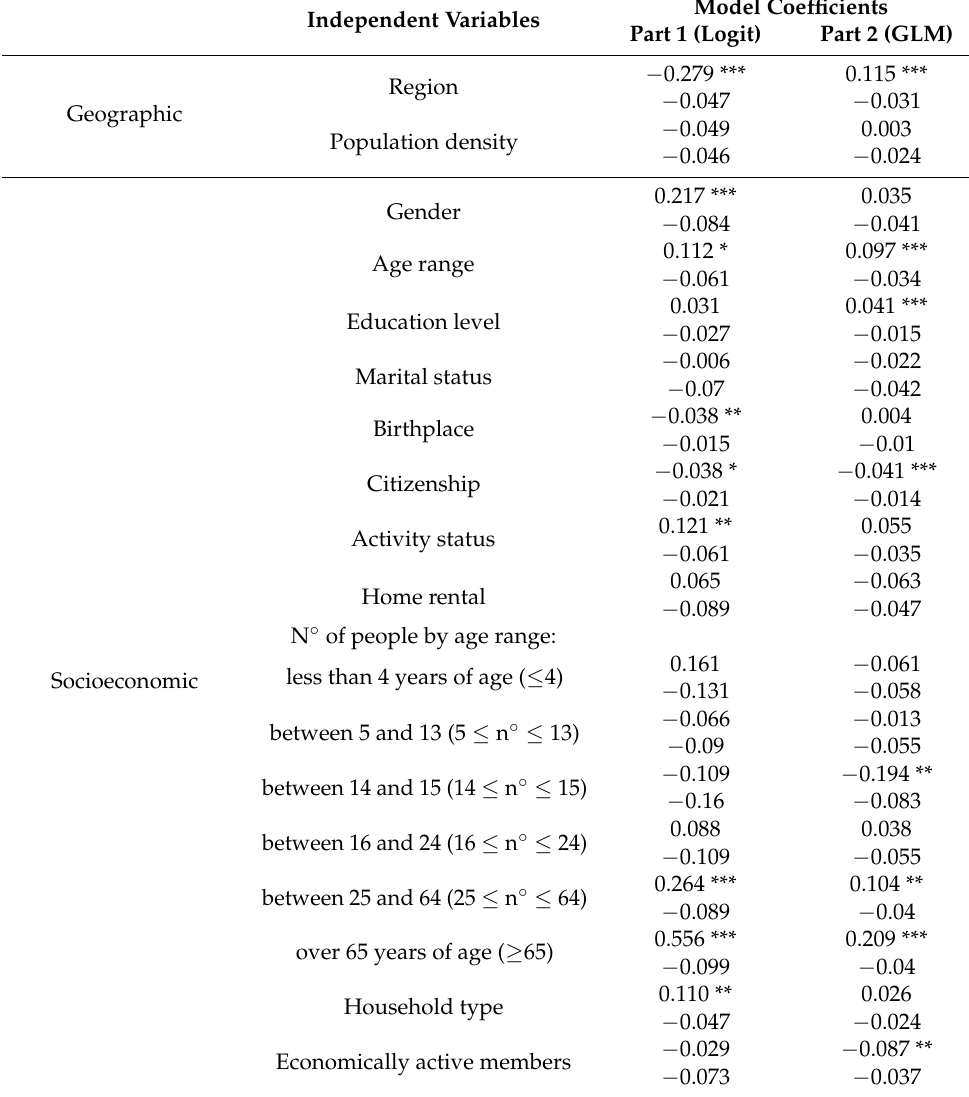
Table 3. Model coefficients of the independent variables for Part 1 and Part 2 of the two-part model. Independent